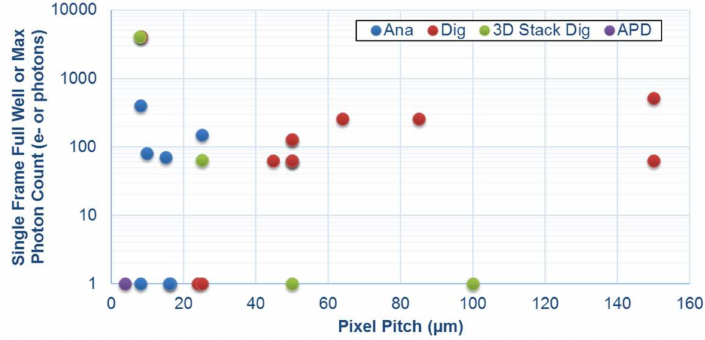
Figure 3. Maximum photon count of SPAD pixels grouped by architecture in comparison to the pixel area.